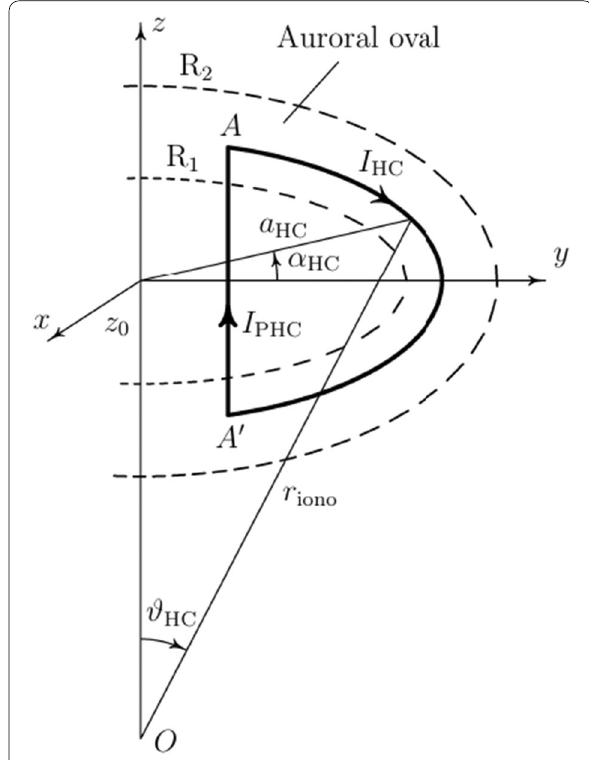
Fig. 17 The geometry considered to derive the magnetic field generated by a wire lying in the westward auroral electrojet and carrying the Hall current I HC along a circular arc. The arc has the geocentric colatitude ϑ HC , radius a HC = r iono sin ϑ HC and is shifted along the z axis by z 0 = r iono cos ϑ HC . The arc extends from − α HC to α HC , where α HC is the angle counted counterclockwise from the y axis in the horizontal plain. The Hall currents I HC are enclosed by the polar-cap Hall current I PHC that flow sunwards across the polar cap along the circular arc A − A